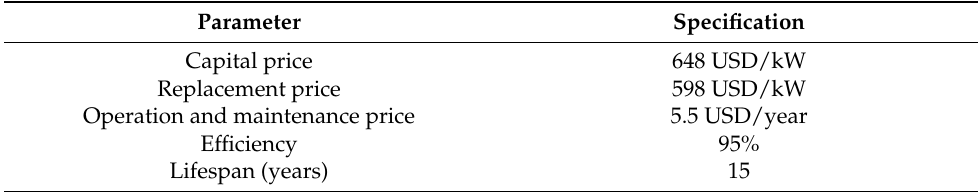
Table 4. Technical and economic data of the